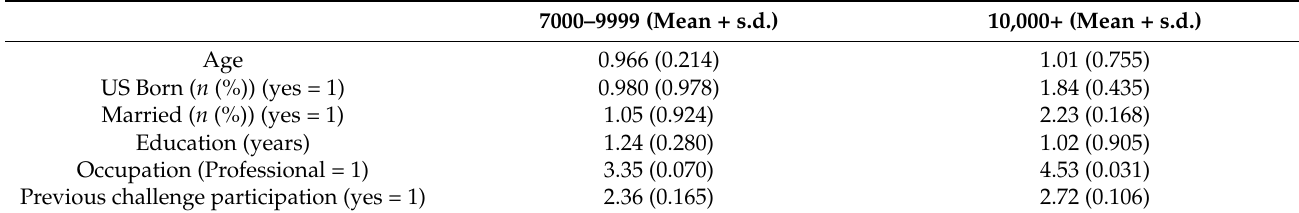
Table 3. Odds ratios from logistic regression prediction baseline step thresholds adjusting for demographic characteristics (< 7000 is the reference category). 7000–9999 (Mean + s.d.)